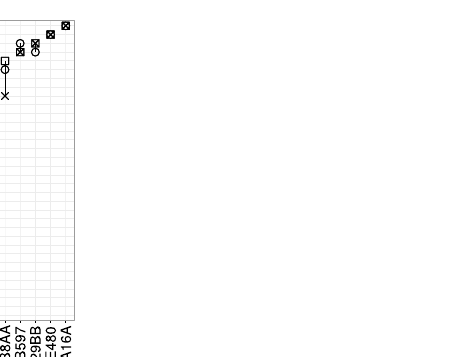
Figure 4. Aggregated leading-following network for the GB2 colony in 2008.Nodes represent individual bats (indicated by a hexadecimal numberinside the circle). Directed links represent following behaviour.Node colors indicate eigenvector centrality, whereas node sizesindicate in-degree centrality. The four individuals with highesteigenvector centrality are shown in the middle. Note that for thesake of illustration, links show only unique L/F events. I.e.leading-following between the same leader and follower, but todifferent roosts, are omitted to maintain the readability of thegraph. Total number of unique L/F events is 262, while the totalnumber of L/F events, including multiple leading-following betweenthe same individuals, is 321 (Table 4).